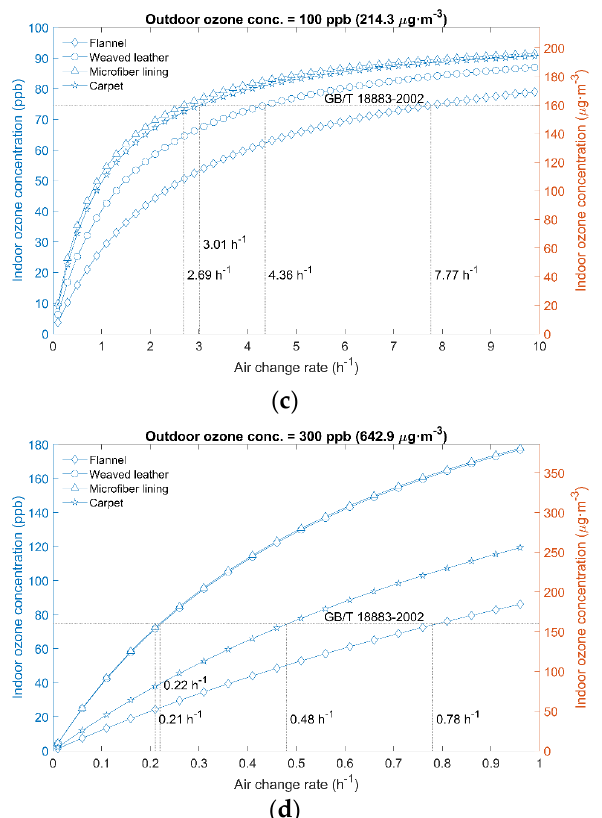
Figure 7. The effect of ventilation rates on indoor ozone concentrations by considering ozone deposition on indoor materials. ( a ) On wood-based panels; outdoor ozone concentration = 100 ppb. ( b ) On wood-based panels; outdoor ozone concentration = 300 ppb. ( c ) On synthetic fibers; outdoor ozone concentration = 100 ppb. ( d ) On synthetic fibers; outdoor ozone concentration = 300 ppb.